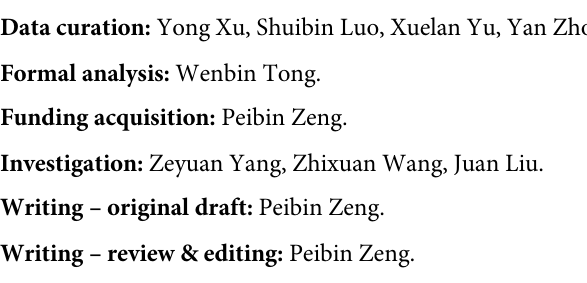
S1 Fig. The ethnics statements approved by the ethics committee of West China Fourth